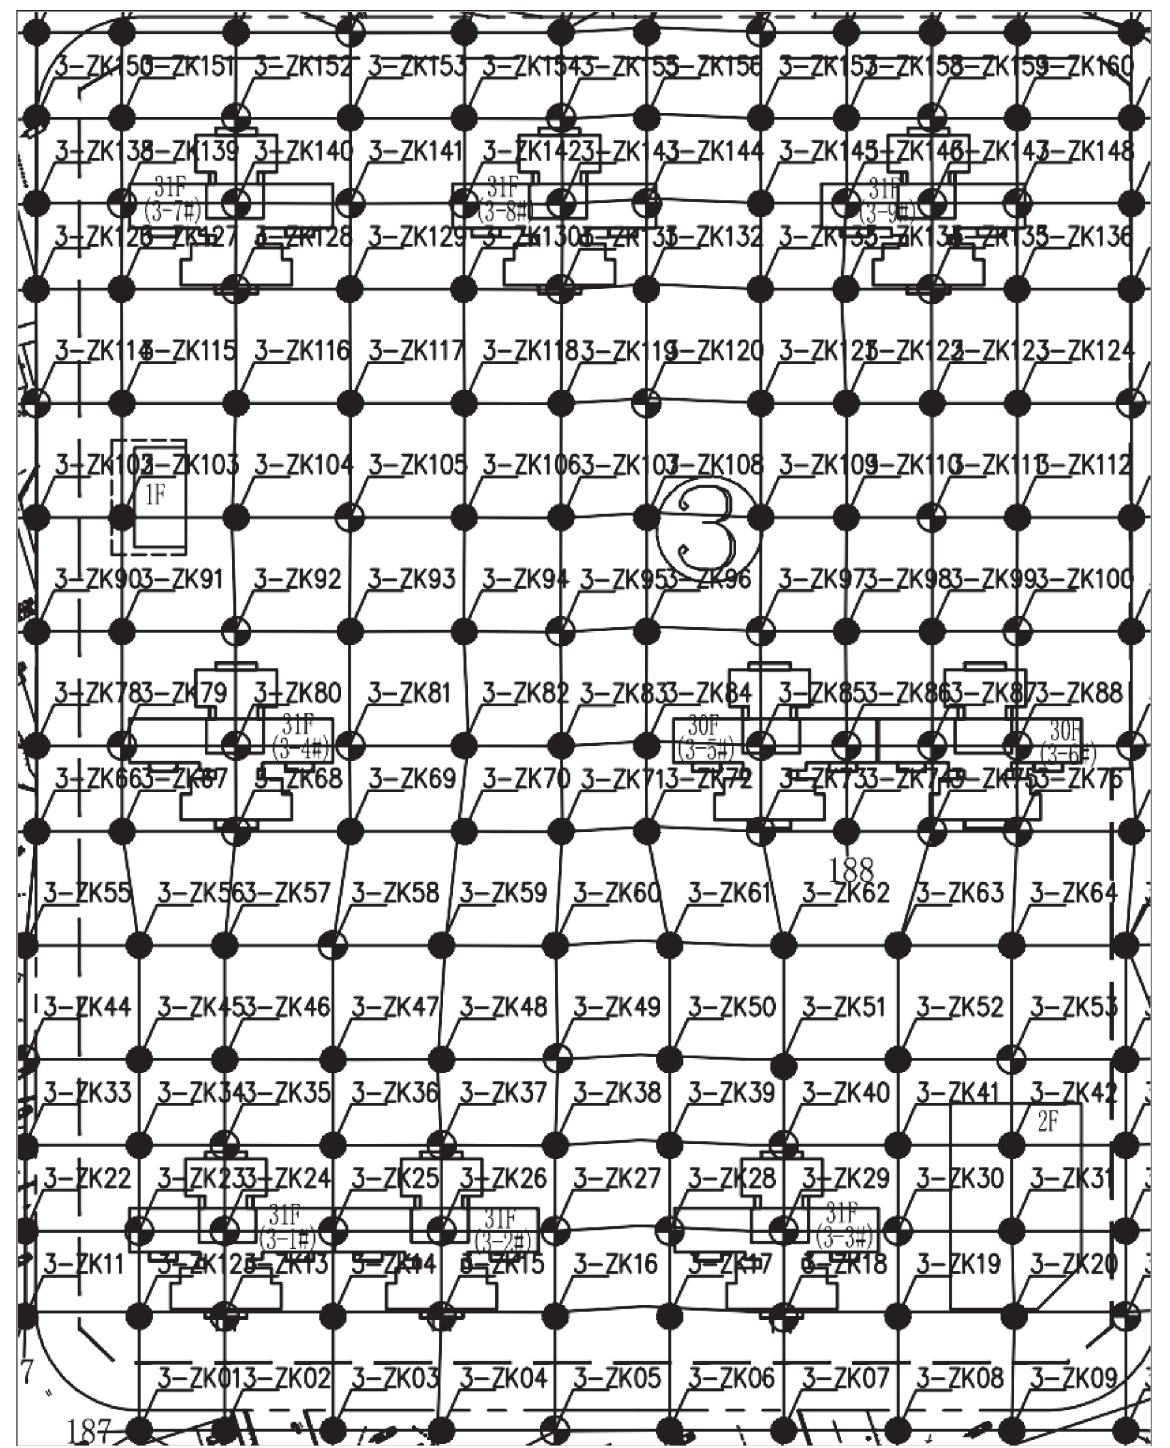
Figure 4: Drilling plan of the project